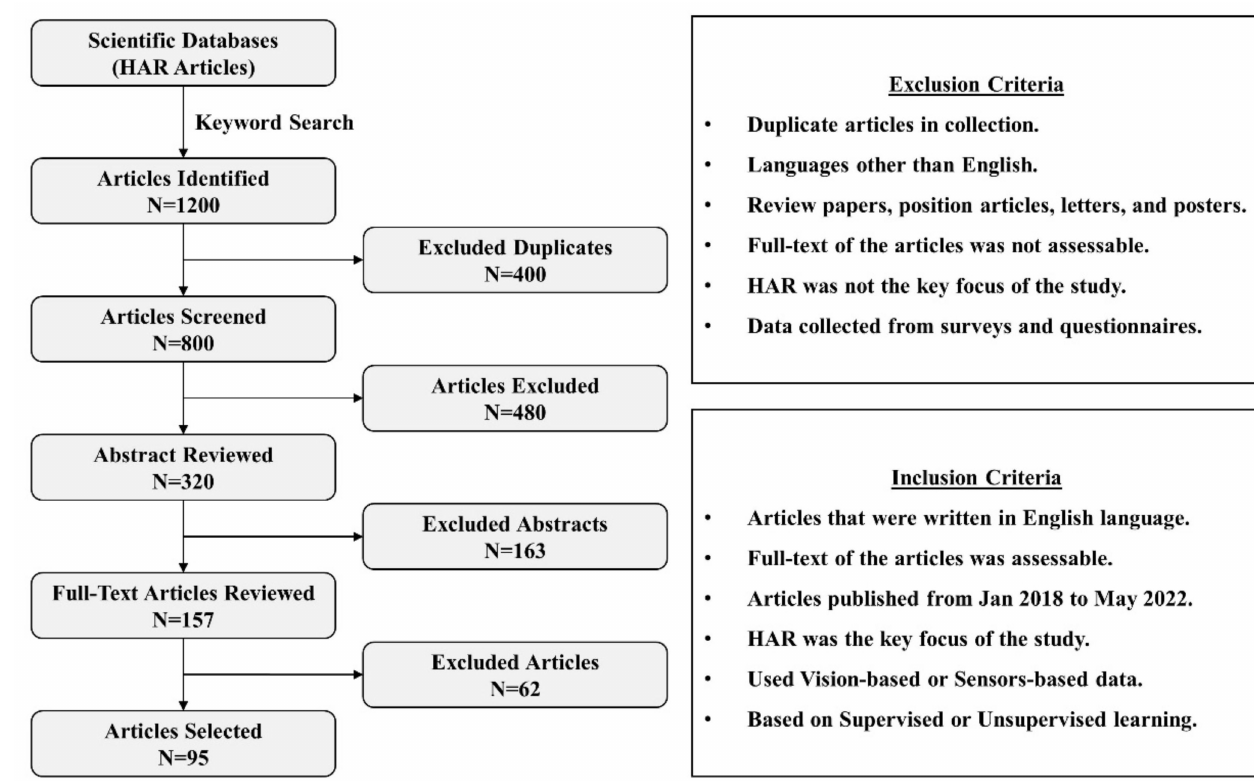
Figure 1. Steps performed for selection of